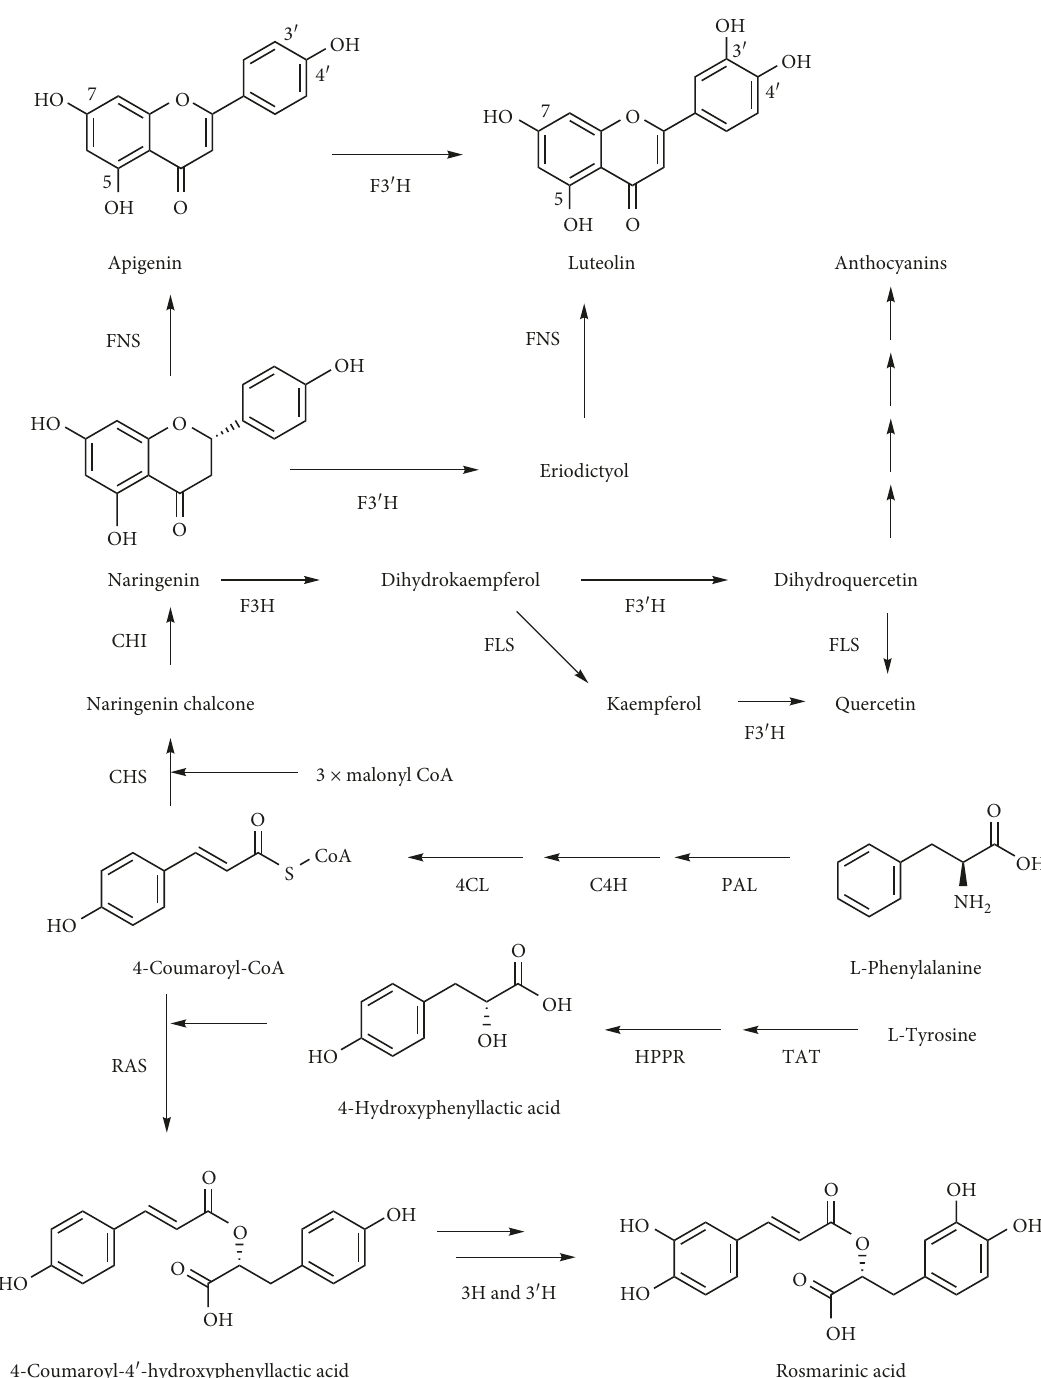
Figure 3: Proposed biosynthetic pathways for apigenin, luteolin, rosmarinic acid, and anthocyanins in perilla plants. Core enzymes involved in the biosynthesis of phenylpropanoid, flavone, and anthocyanin skeletons are shown. F3 H, flavonoid 3 -hydroxylase; FNS, flavone synthase; F3H, flavanone 3-hydroxylase; FLS, flavonol synthase; CHI, chalcone isomerase; CHS, chalcone synthase; PAL, phenylalanine ammonia-lyase; C4H, cinnamic acid 4-hydroxylase; 4CL, 4-coumaric acid: CoA ligase; TAT, tyrosine aminotransferase; HPPR, ′ ′ hydroxyphenylpyruvate reductase; RAS, hydroxycinnamoyl-CoA: hydroxyphenyllactate hydroxycinnamoyl transferase; 3H and 3 H, hydroxycinnamoyl-hydroxyphenyllactate 3-and 3 ′ ′